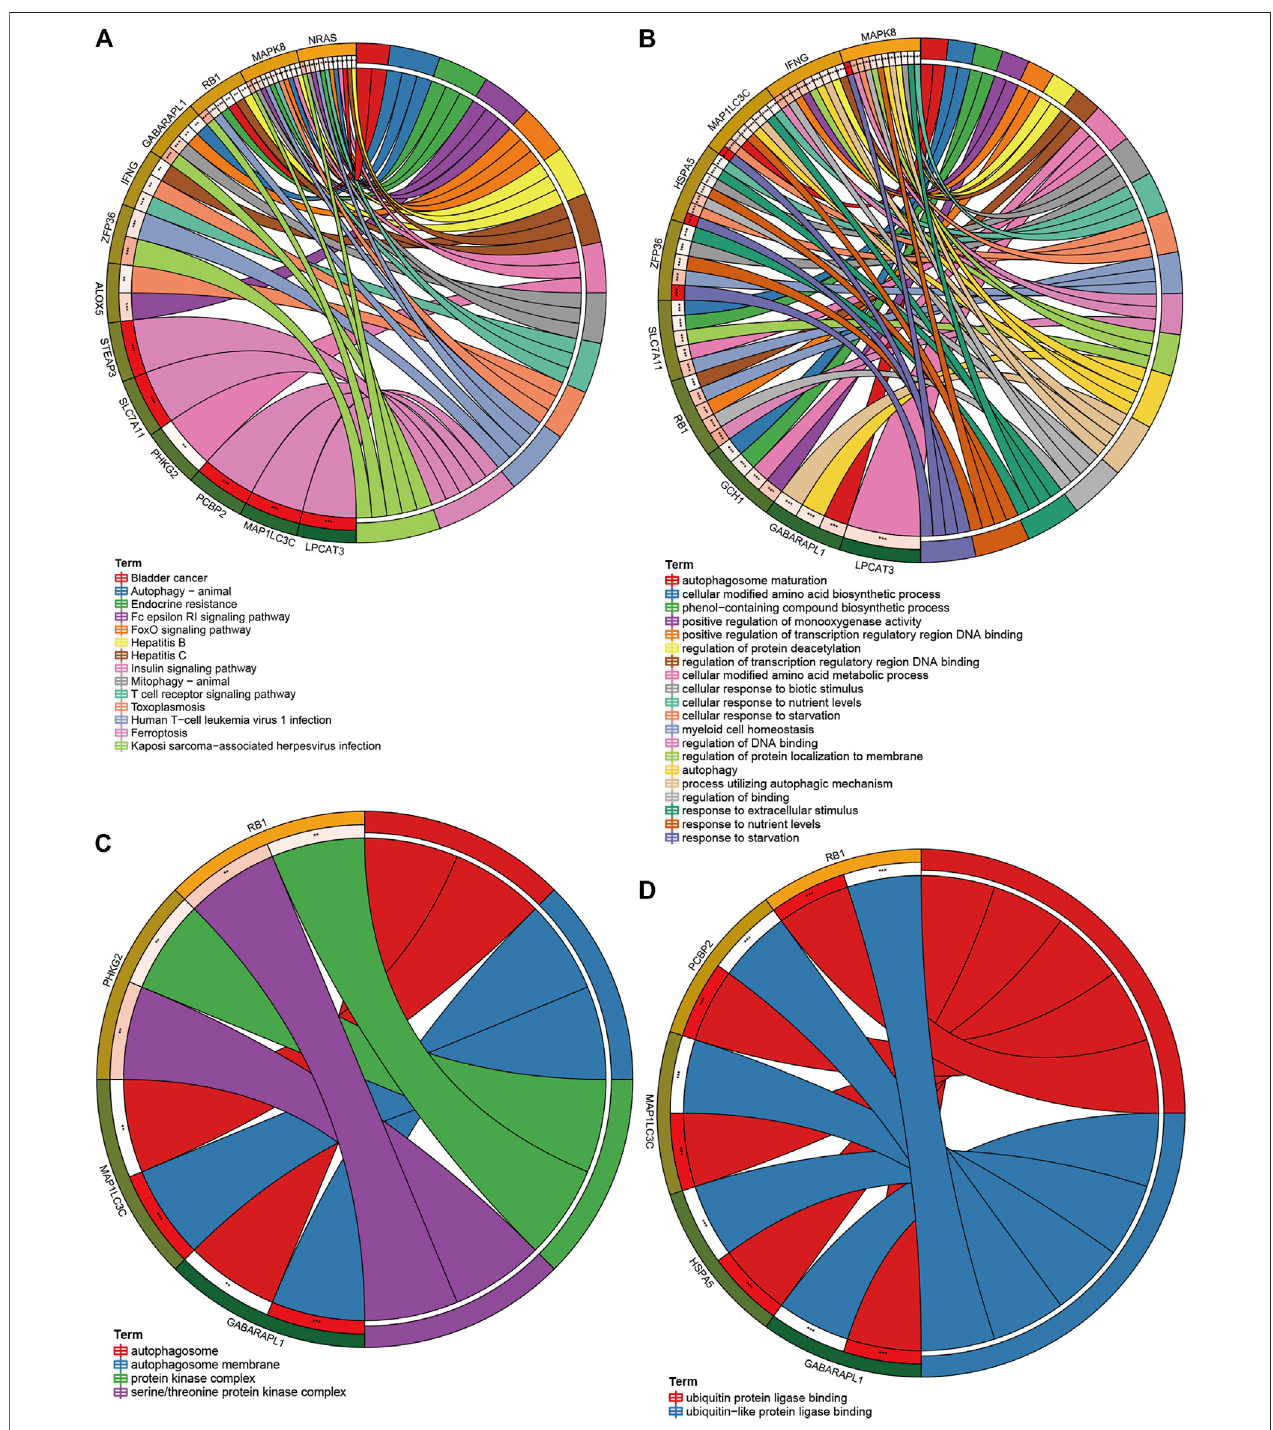
FIGURE 8 | De fi ning FRG-related pathways and immune cells by GSEA and GSVA analysis. (A,B) GSEA analysis between the low and high E-FRG score groups. (C) GSVA analysis on FRGs in the TCGA training set which provided 22 FRG-related pathways. (D) Correlation of 22 TIICs with 22 FRG-related pathways. Pearson ’ s coef fi cient was used for signi fi cance test. * p < 0.05, ** p < 0.01, and *** p < 0.001.